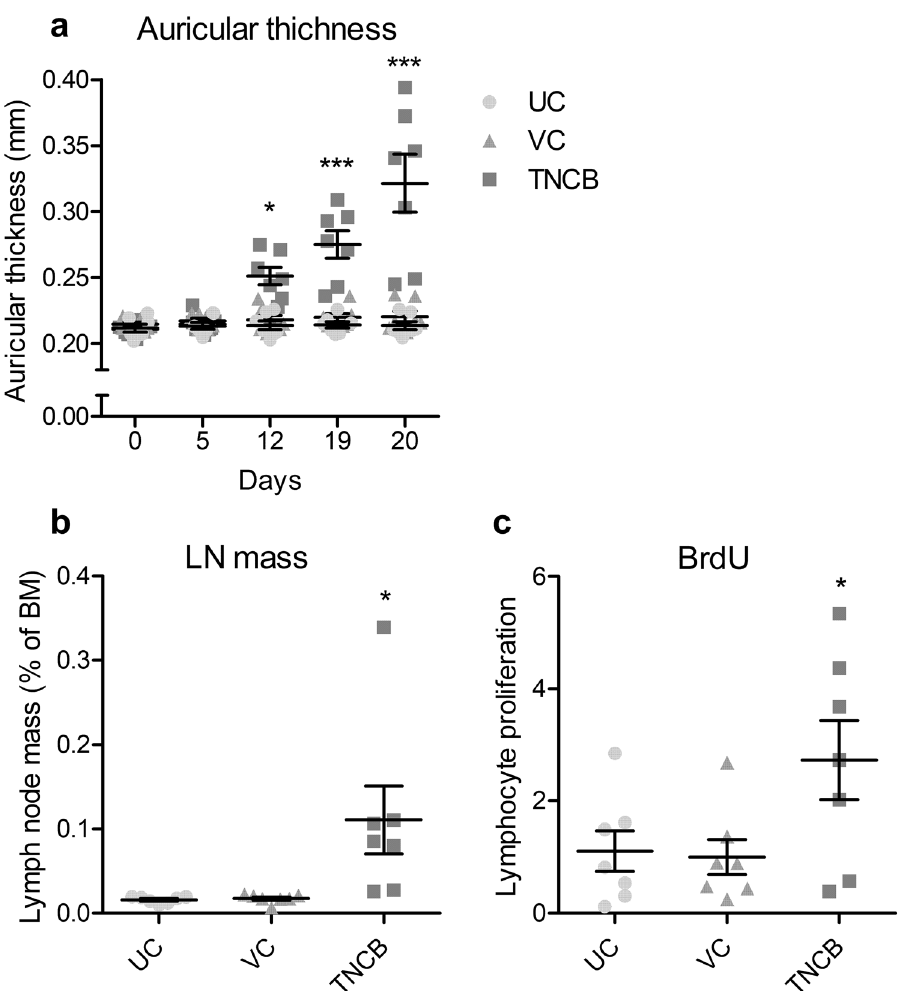
Figure 6. Changes in the auricle and auricular lymph nodes of mice after one TNCB induction and three challenges, 1 week apart. Left auricular thickness ( a ) was measured in the untreated (UC) and vehicle-only (VC), or TNCB-treated mice on days 0, 5, 12, 19, and 20 after induction. Auricular lymph node-to-body mass ratio ( b ) and BrdU-labeled lymphocyte proliferation in the lymph nodes ( c , ratio to vehicle control) were measured 24 h after the final treatment. The graphs are scatter plots, where each symbol represents an actual measurement, and the centerlines and error bars represent the mean and standard error, respectively. Asterisks indicate levels of significant differences from the vehicle control: * P < 0.05, *** P <